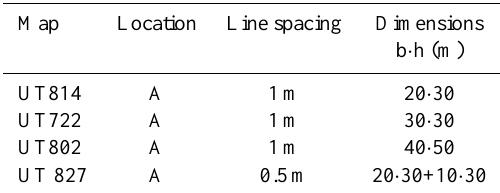
Table 1. Magnetic maps carried out in “Madonna della Valle”